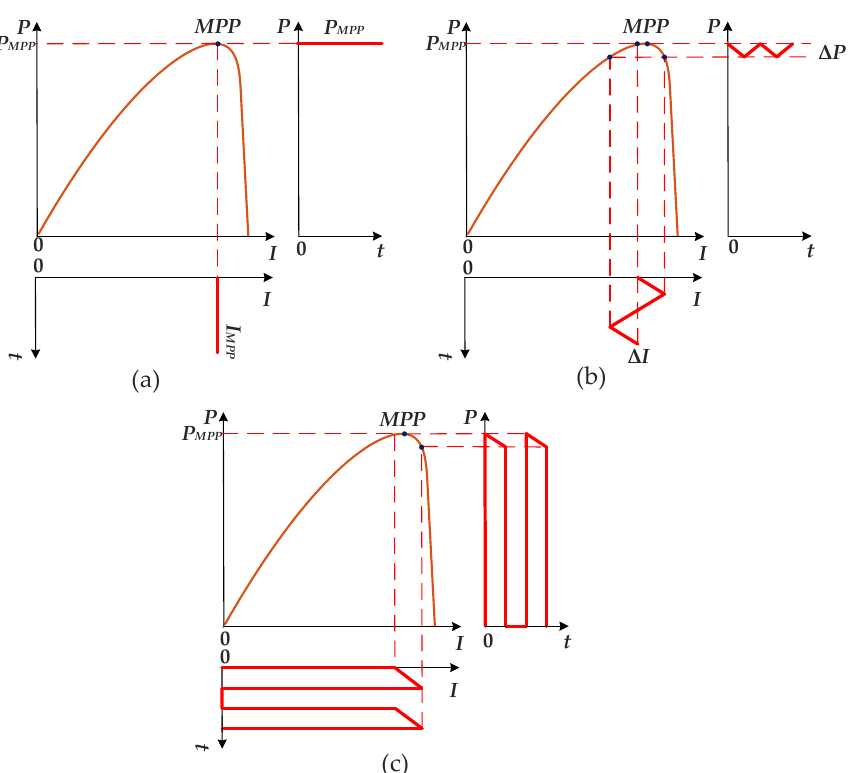
Figure 3. The Impact of MPPT input current shape on the value of solar battery power: ( a ) continuous current; ( b ) current with ripple Δ I ; ( c ) discontinuous current. There is an input inductor L in the boost converter [12]. This inductor produces continuous current and can be used directly as an MPPT (Figure 4a). Because it has a series-connected transistor, buck and buck/boost converters have an extra capacitor C F that filters the input current, as shown in Figure 4b.